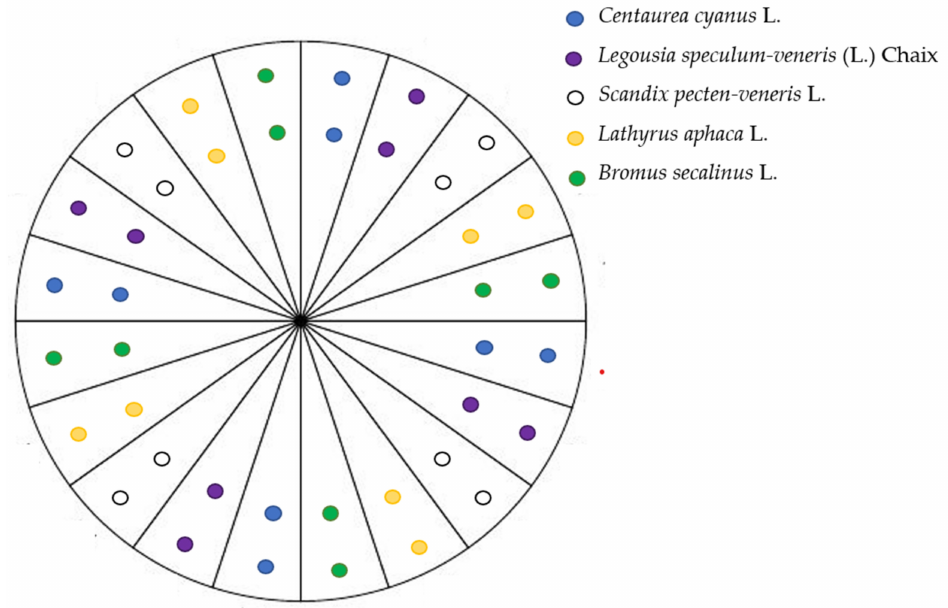
Figure 1. Sowing design for the five selected species in each of the 45 pots, simulating an arable plant